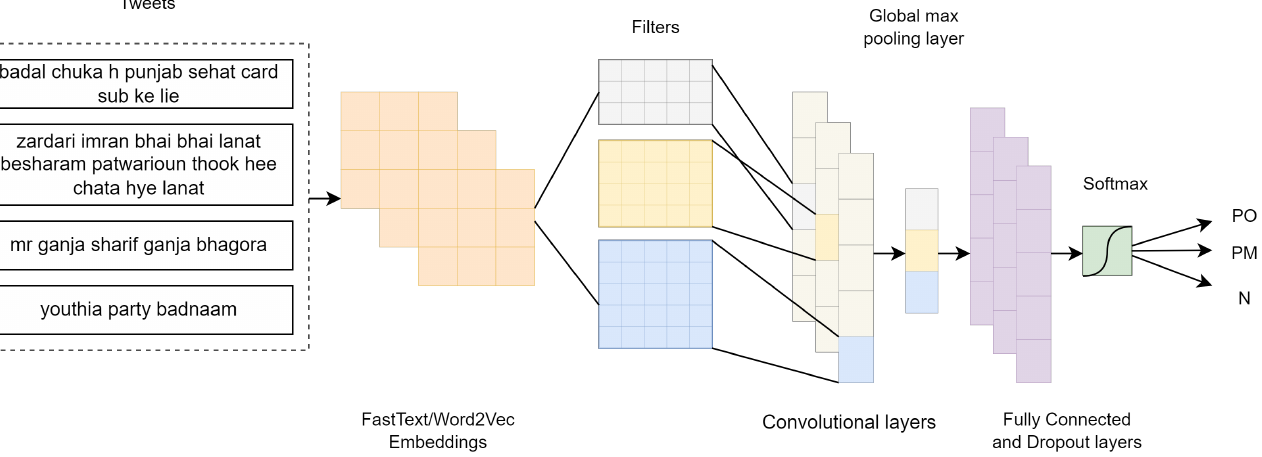
Figure 7. An abstract view of proposed 1-D convolutional neural network